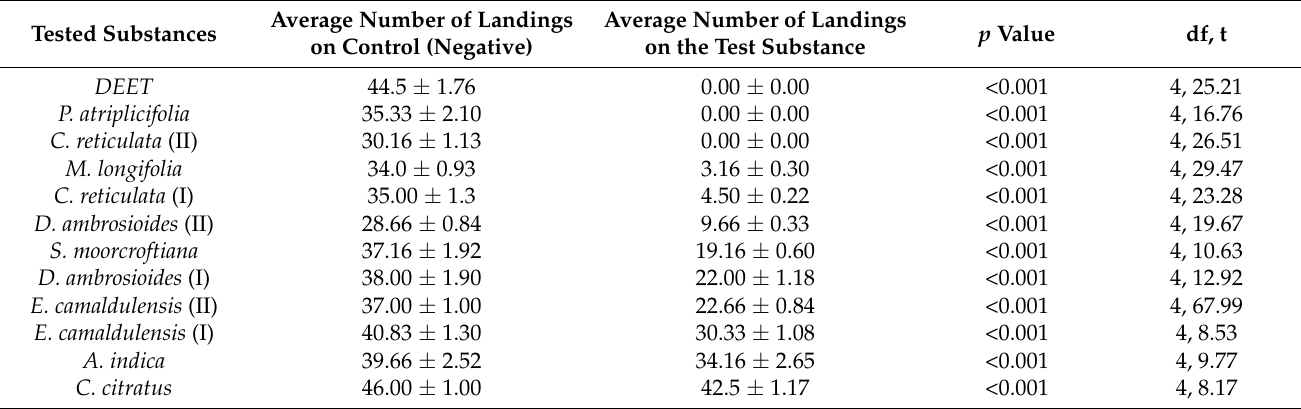
Table 3. Mosquito landings on human hand treated with different essential oils, DEET and nega- tive control.